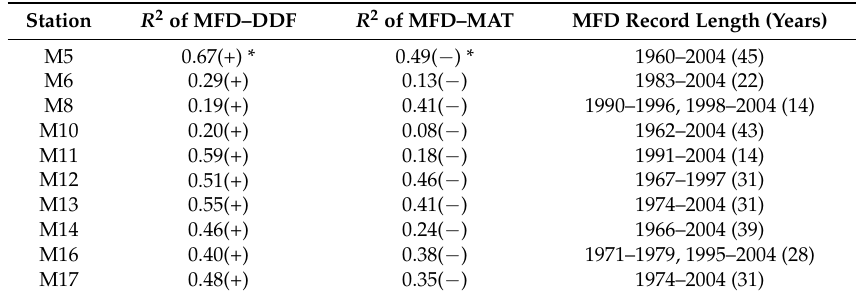
Table 3. Correlations between maximum frozen depth (MFD) and DDF at weather stations, compared to correlations between MFD and mean air temperature